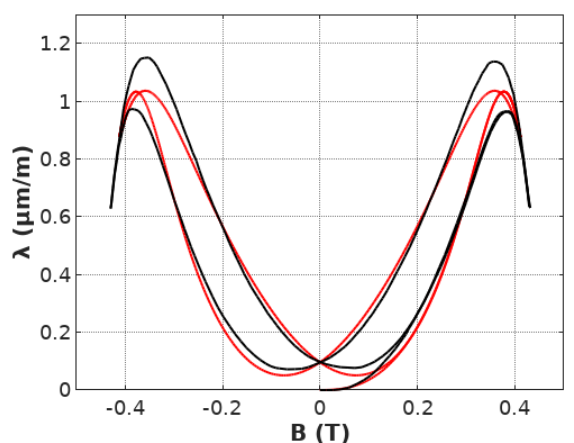
Figure 7. Magnetostrictive B ( H ) hysteresis loop of Mn 0.70 Zn0. 24 Fe 2.06 O 4 ferrite for power application modeled by the first order inertial element, calculated for the parameters: a 1 = 9.3 𝜇𝑚 , B switch = 0.248 T, k = 0.178 (experimental measurements — black line, results of modeling — red line).